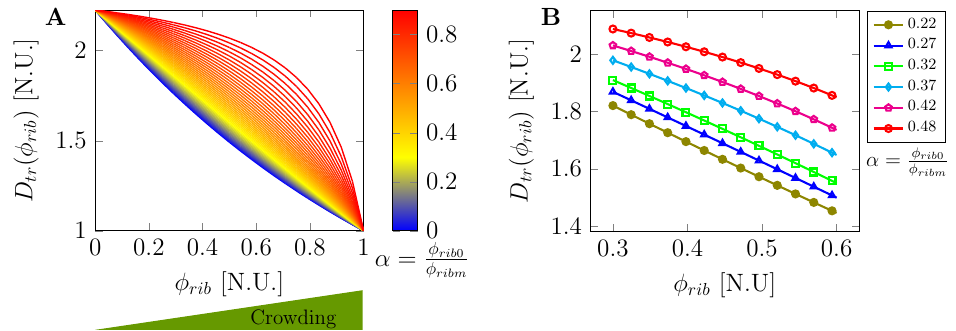
Figure 2. Dependence of tracer diffusion coefficient ( D tr ) on macromolecular crowder concentration φ rib : ( A ) effective concentration-dependent tracer diffusion coefficient for several values of α ( B ) dependency of D tr on crowder concentration for selected values of ribosome crowder concentra- tion and control parameter in the range of α = 0.35 reported in